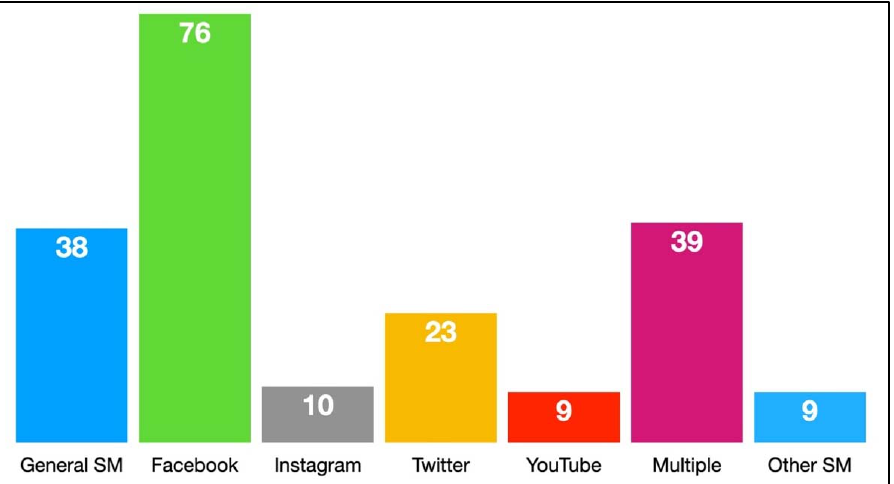
Figure 8. Distribution of studies included in the systematic review, by social media platform.